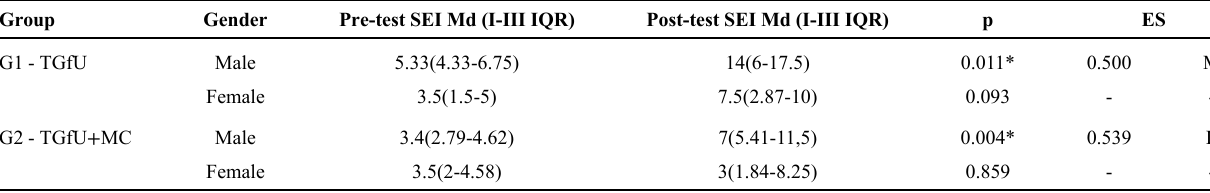
Table 3 - The technical skills considering time and gender effect for both groups.